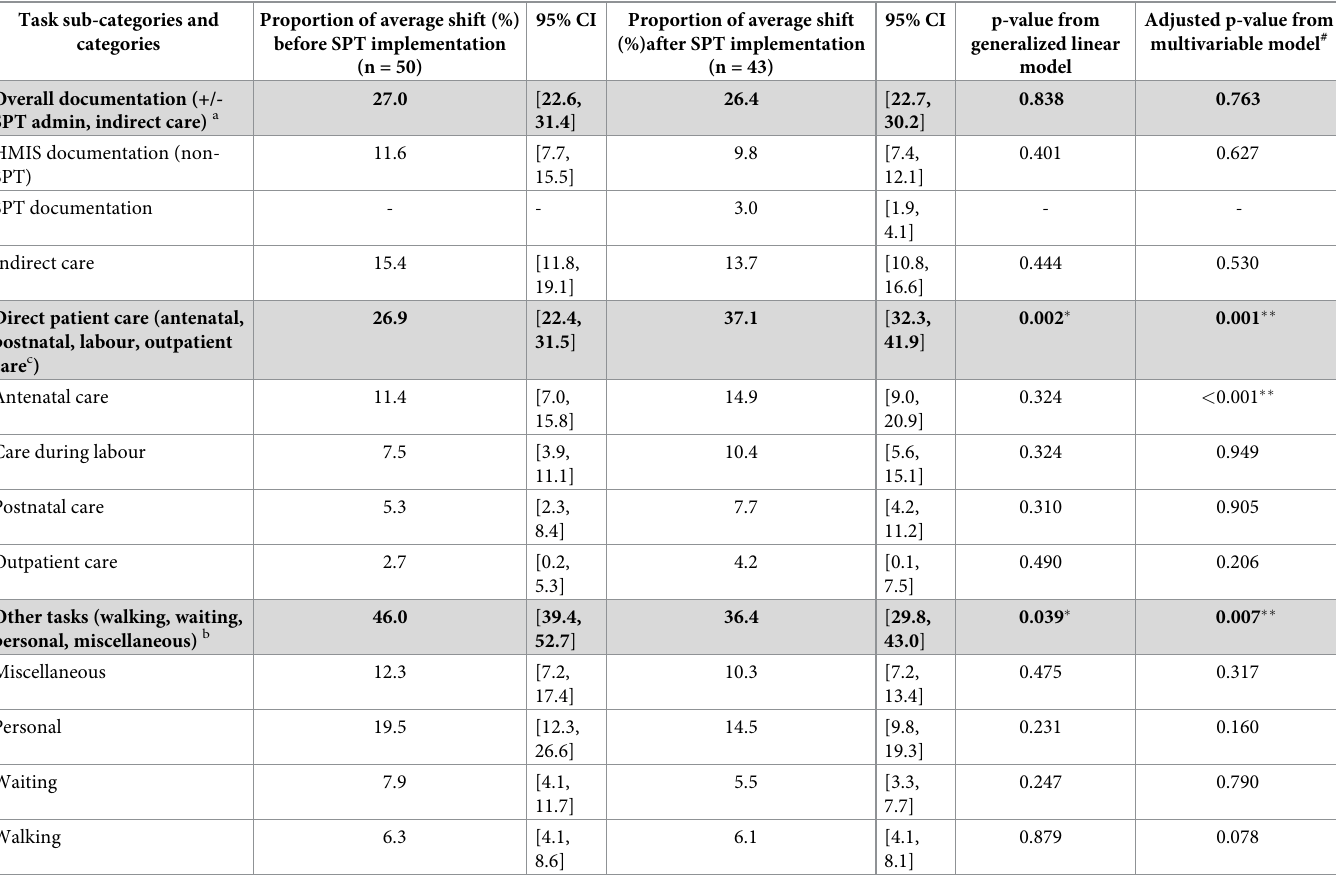
Table 2. Proportion of time spent per average shift by task sub-categories and categories. Task sub-categories and